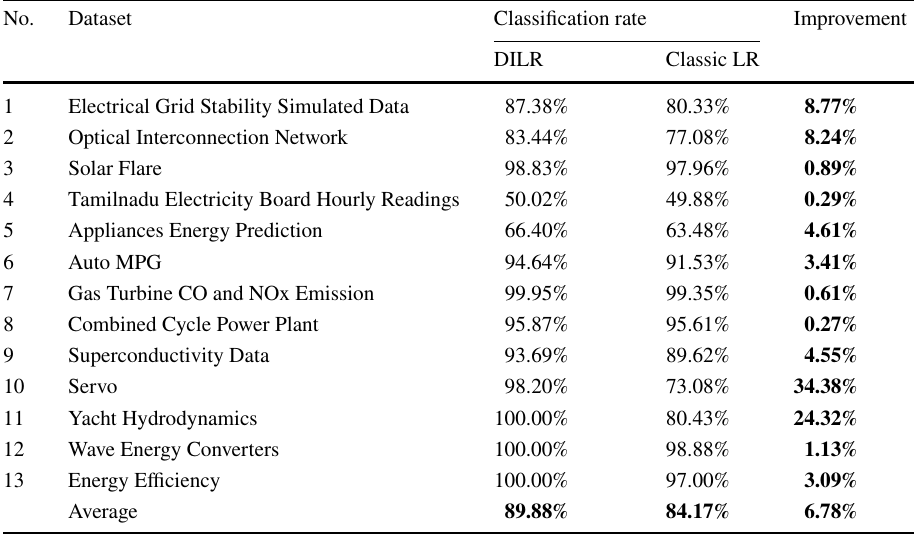
Bold values indicates the average and improvement Table 5 Classification rate of the presented DILR and conventional LR classifiers for all datasets